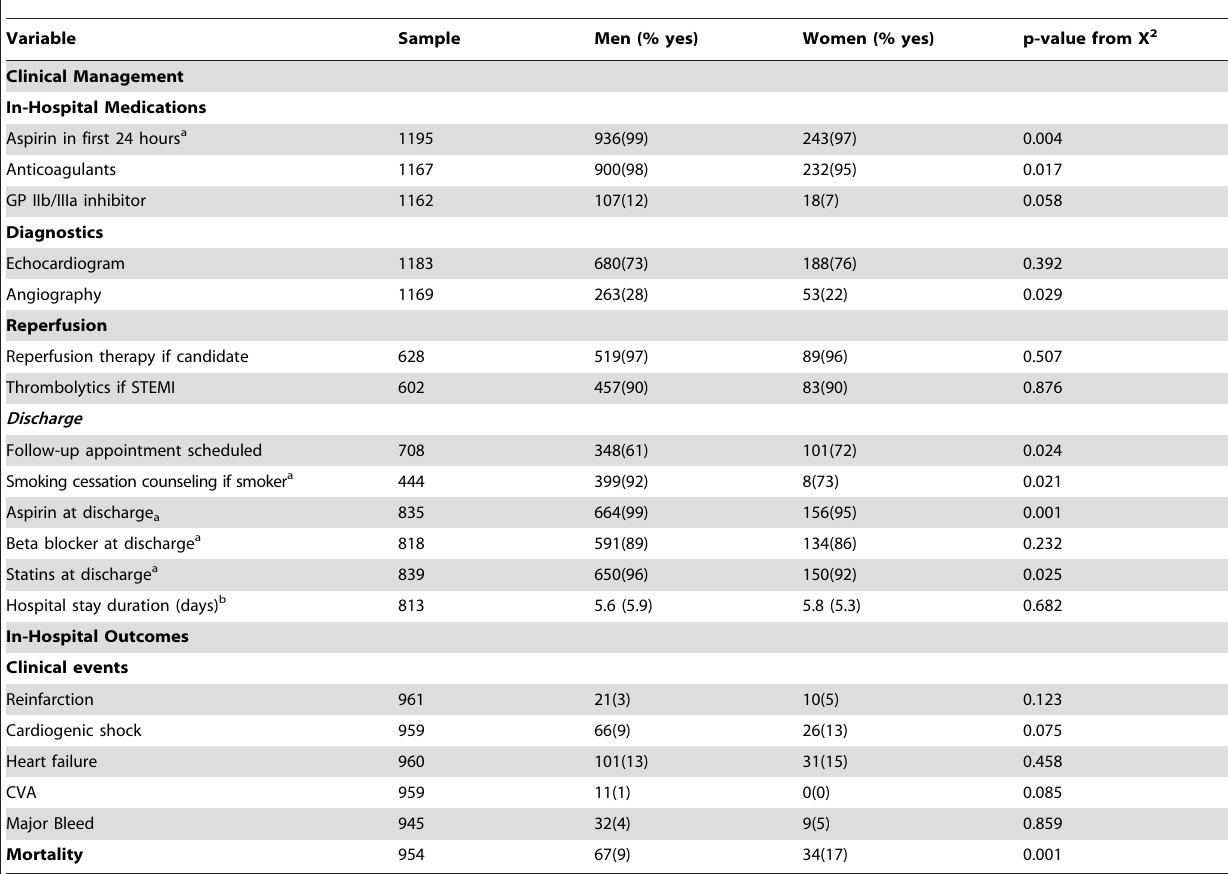
Table 2. Gender differences in clinical management and in-hospital